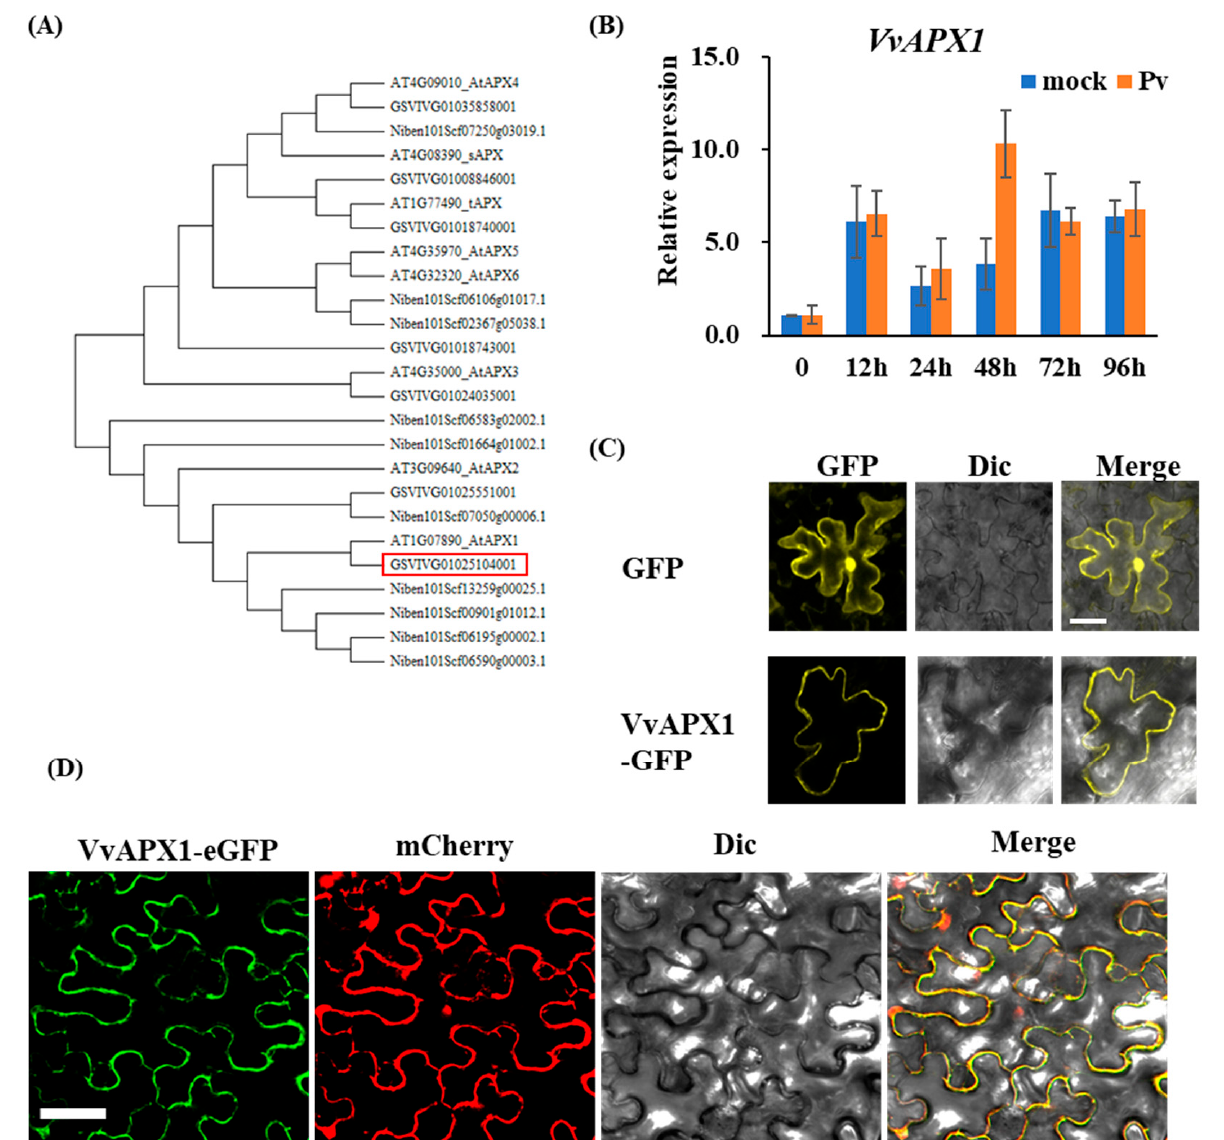
Figure 3. Phylogenetic, Transcript pattern, and subcellular analysis of VvAPX1. ( A ) Phylogenetic analysis of APX in Vitis vinera , Nicotiana benthamiana , and Arabidopsis thaliana . Red box represents VvAPX1. Phylogenetic tree was constructed using the neighbor-joining method with MEGA-X. ( B ) Transcript pattern of VvAPX1 during P. viticola infection. The leaf discs of Vitis vinifera ‘Thompson Seedless’ were inoculated with P. viticola . Samples were harvested at 0, 12, 24, 48, 72, and 96 hpi for RNA extraction. ( C ) Subcellular localization of VvAPX1 in V. vinera ‘Thompson Seedless’. Scale bar = 10 μ m. ( D ) Subcellular localization of VvAPX1 in N. benthamiana. Scale bar = 50 μ m.